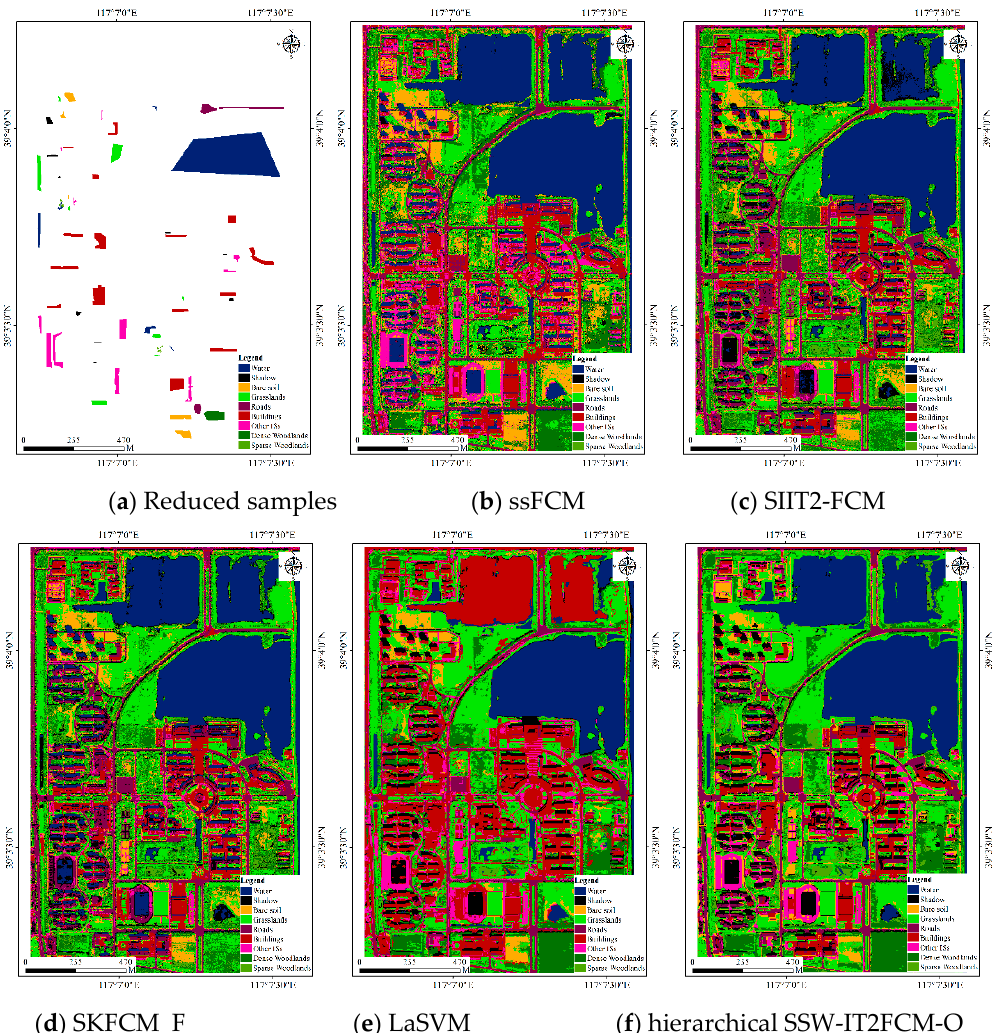
(f) hierarchical SSW-IT2FCM-O Figure 15. Classification results of five methods when the sample size was reduced to 8%. Table 8. The overall accuracies and Kappa coefficients produced by the five methods if the sample